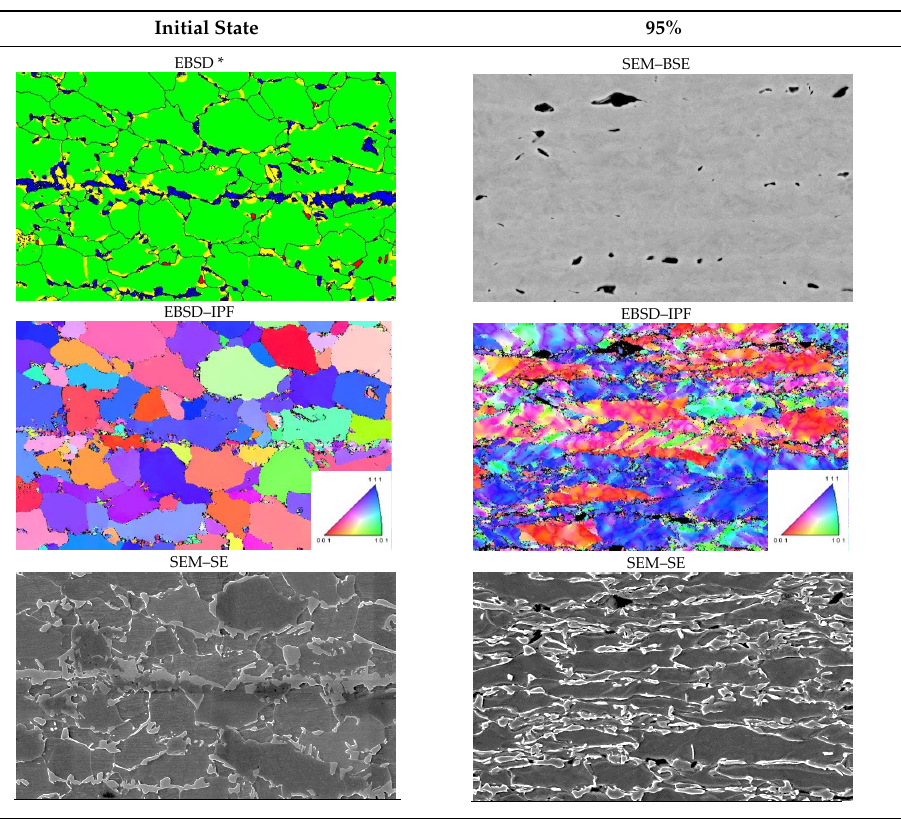
Table A17. Damage evolution along grain boundaries DP600.